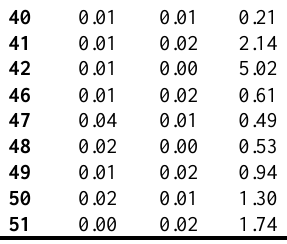
Table 3. Accuracy check on 48 CPs when testing the GCSs method. X, Y and Z indicate the error along the homonymous direction. The C2C distances between the point cloud derived from the GCSs method, the one deriving from the GCPs method and the photogrammetric one are reported in Figure 11. Analyses were performed using CloudCompare software. For the same reason as above, the C2C reported distance refers to the Z direction. Different sections of the three-point clouds were extracted through a polyline drawn in correspondence with the road centreline. The photogrammetric point cloud served as a reference.